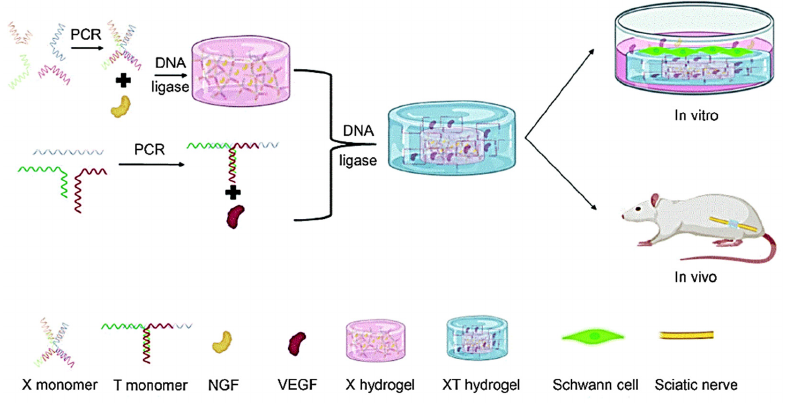
Figure 4. Repair of peripheral nerve defects by DNA hydrogel + VEGF/NGF. (Adapted with permission from [61]. Copyright (2021) Royal Society of Chemistry.)